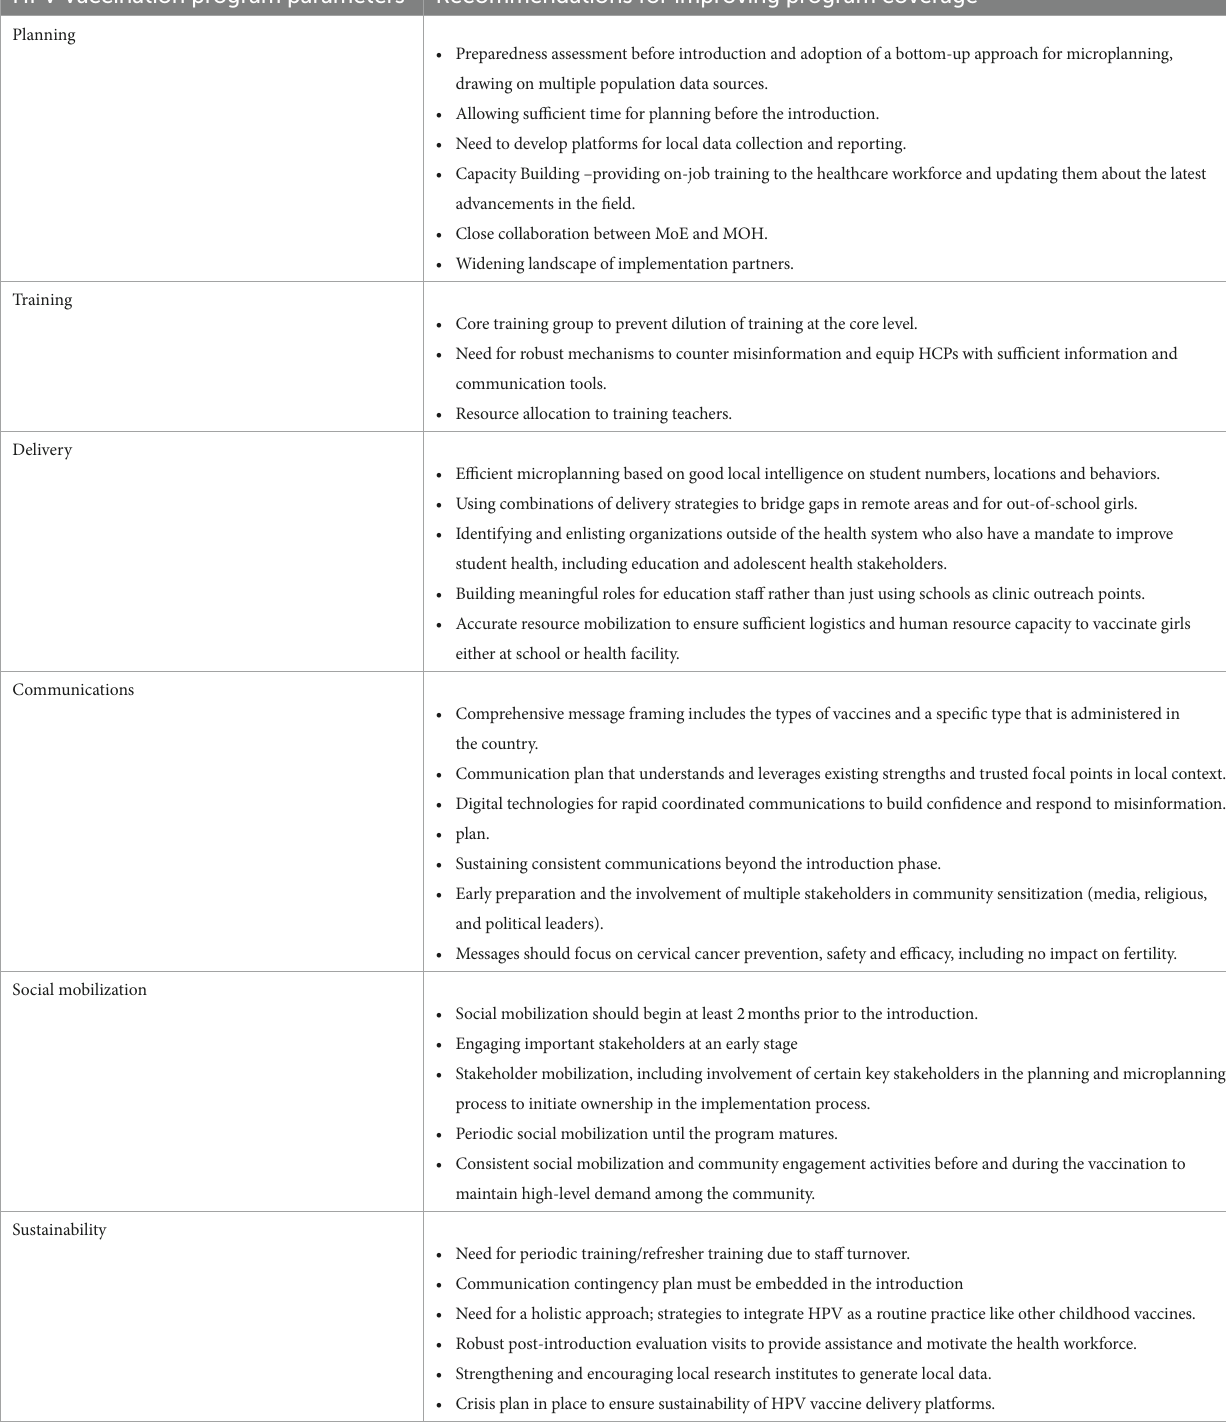
TABLE 3 Recommendations for the sustainable HPV vaccination program. HPV Vaccination program parameters Recommendations for improving program